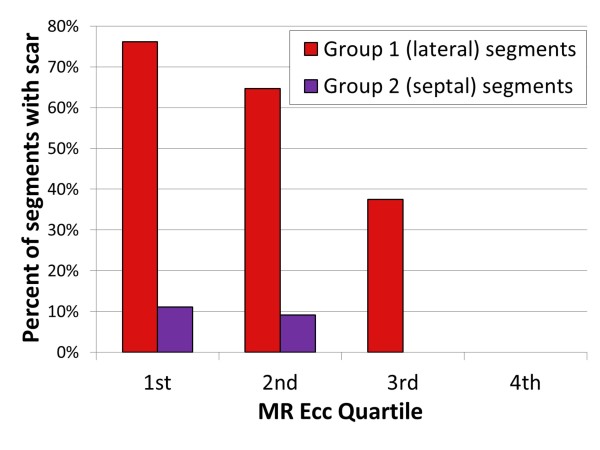
Increased proportion of scar in lateral versus septal segments across CMR circumferential strain quartiles. The figure shows an increased proportion of scar in group 1 (lateral) segments versus group 2 (septal) segments based on the analysis of all 156 myocardial segments. This effect was consistent across all lower three CMR quartiles of Ecc, indicating that there is increased prevalence of segmental scar at any level of segmental Ecc in group 1 (lateral) segments versus group 2 (septal) segments. In other words, the association between depressed Ecc and scar has a significant regional dependence, with dysfunctional lateral segments much more likely to have scar than dysfunctional septal segments. 1st quartile = least negative Ecc (most dysfunctional); 4th quartile = most negative Ecc.